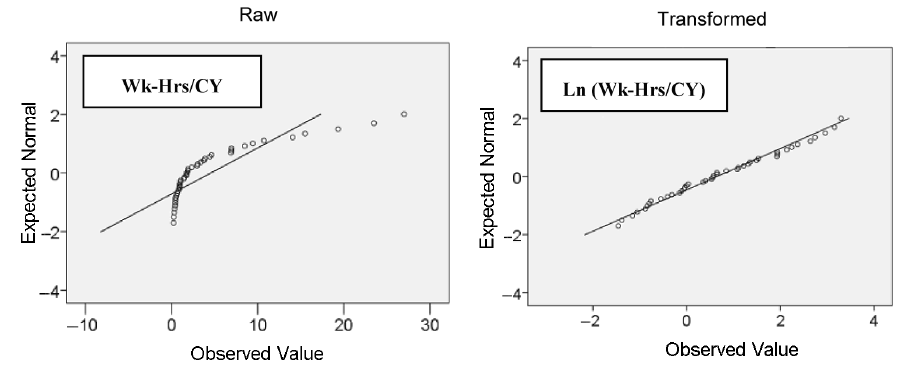
Fig. 3. Q-Q plots of raw/transformed concrete engineering productivity metric Table 2. Test of normality for engineering productivity metrics